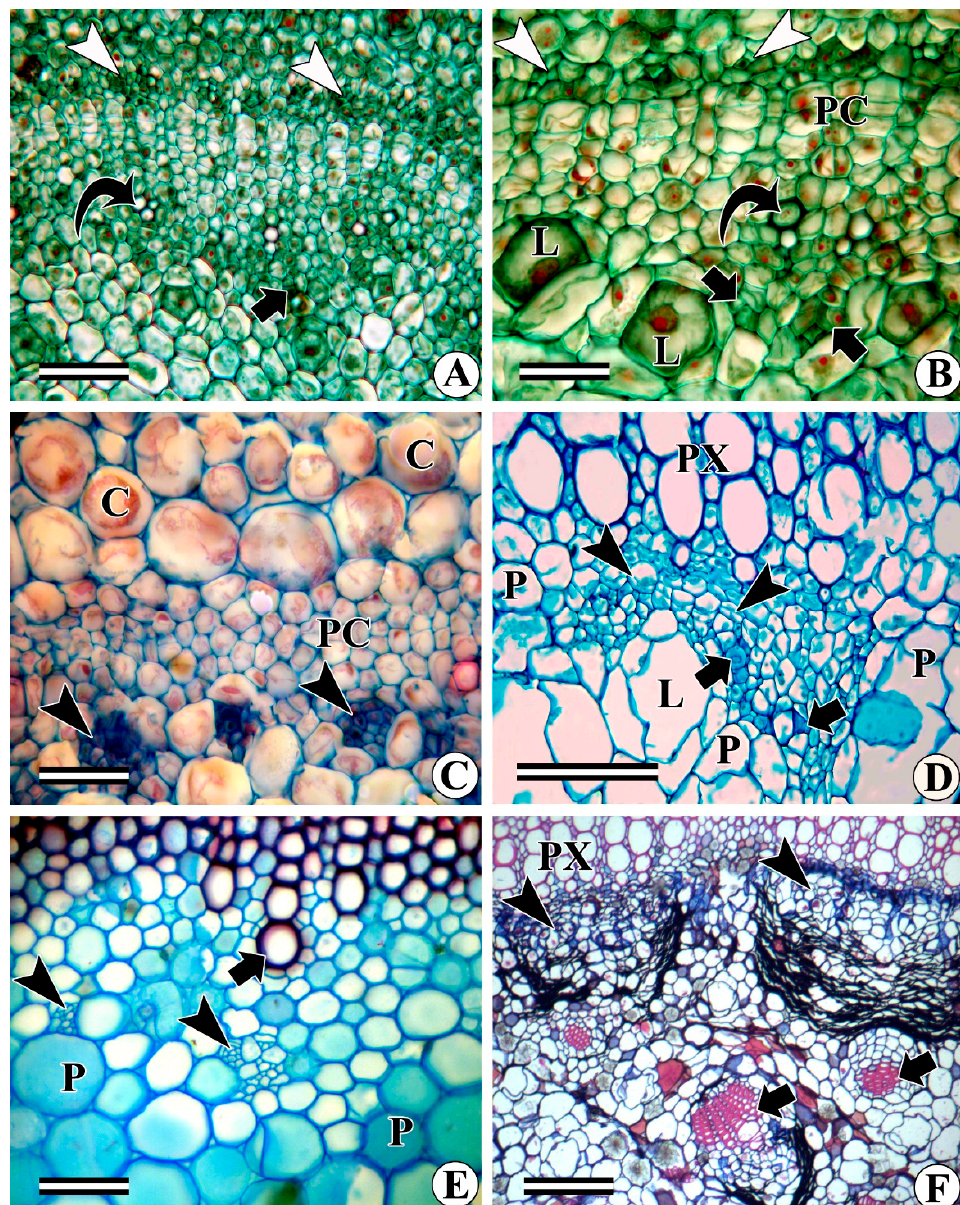
Figure 8. Development of intraxylary protophloem in young stems. ( A ) Initiation of intraxylary protophloem development (arrow) in the young stem of Ipomoea hederifolia . Arrowheads indicate external protophloem and the curved arrow shows the protoxylem. ( B ) Enlarged view showing differentiating intraxylary protophloem (arrows). Arrowheads indicate external protophloem and the curved arrow shows the protoxylem. ( C ) Development of intraxylary phloem (arrowheads) precedes that of regular protophloem in Solanum pseudocapsicum . Note the absence of regular (ex- ternal) protophloem. ( D ) Development of additional intraxylary phloem (arrows) from the pro- cambial cells in I. hederifolia . Arrowheads indicate dividing procambial derivatives. Note the varia- tion in the size of the cells adjacent to the protoxylem (PX) elements. ( E ) Young stem of Argyreia nervosa showing intraxylary phloem (arrowheads) in the pith region and away from the protoxy- lem (arrow). ( F ) Fully grown thick stem of A. nervosa showing intraxylary phloem (arrowheads) on the inner margin of the protoxylem (PX). Arrows indicate medullary bundles. Abbreviations : C = cortex, L = laticifers, P = pith cells, PC = procambium, PX = protoxylem. Scale bars : A, E = 100 µm; B = 50 µm; C = 75 µm; D = 75 µm; F = 200 µm. However, its development in A. nervosa begins close to the protoxylem only in the relatively thick stems after the initiation of the secondary growth stage (described later